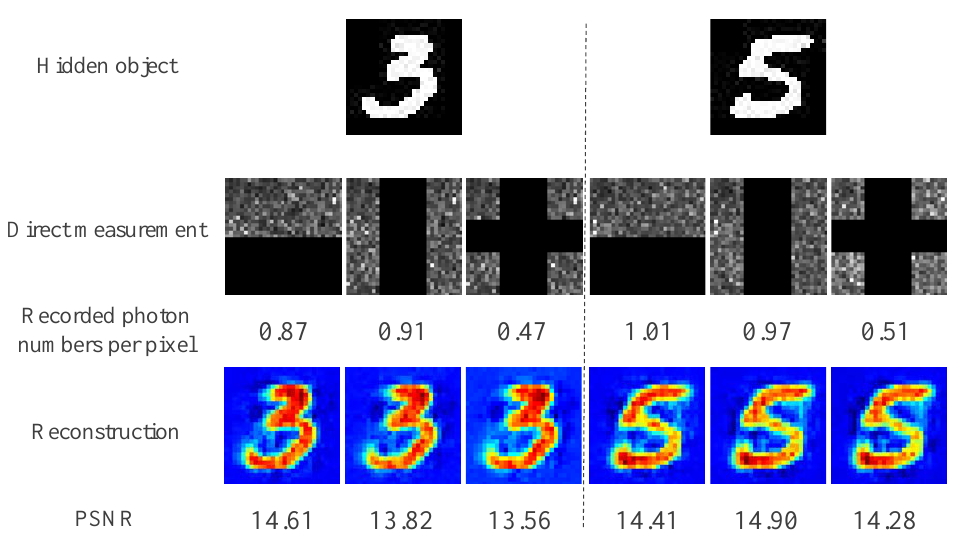
Figure 10. The avoidance–obstacle performance for different occlusion shapes of the proposed method under the photon-limited